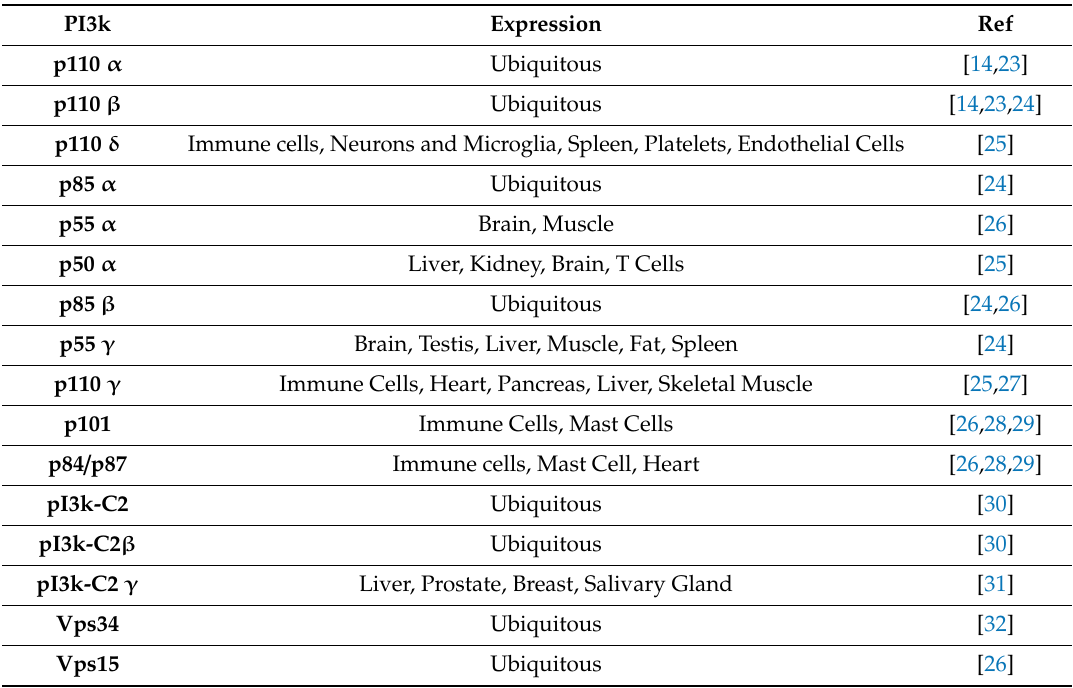
Table 1. Tissue distribution of PI3K